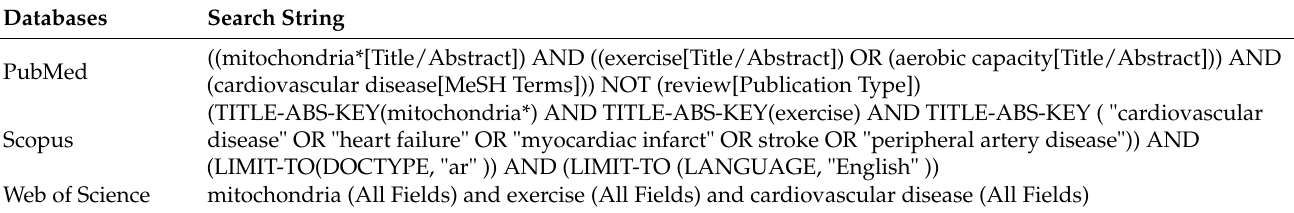
Table 1. Search strategy used in literature